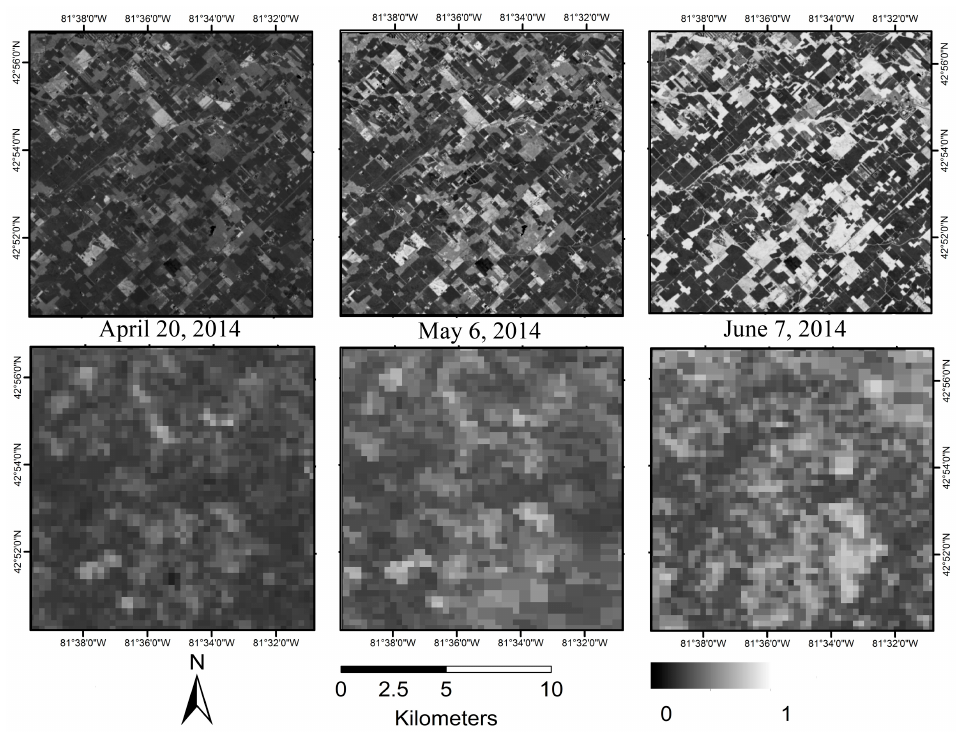
Figure 3. Landsat ( upper row ); and MODIS ( lower row ) NDVI images from three dates in 2014 over a cropland area in Ontario, Canada.